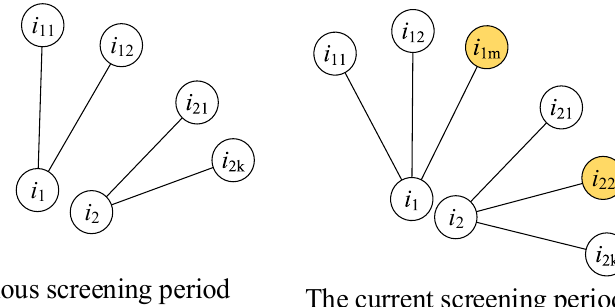
Figure 2. The measuring method for the NC i metric. The left sub-figure shows the contacts of person i 1 and i 2 in the previous screening period. The right sub-figure shows the contacts of person i 1 and i 2 in the current screening period. The person i 1 m and i 22 are two newly added contacts of person i 1 and i 2 .